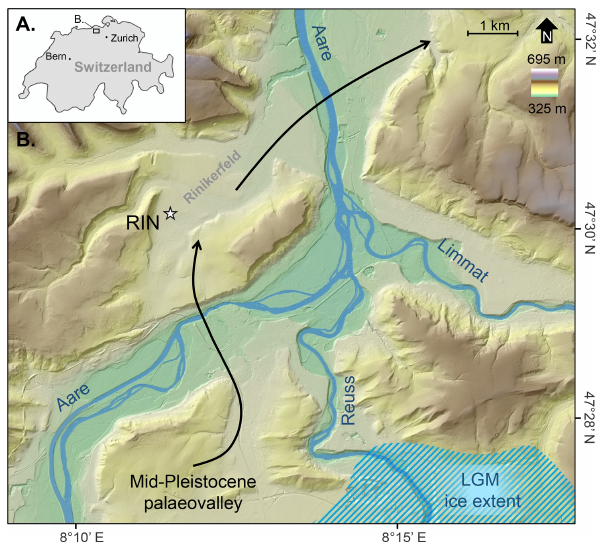
Figure 1. (a) Location of the study area within Switzerland. (b) Overview of the study area and drill site.